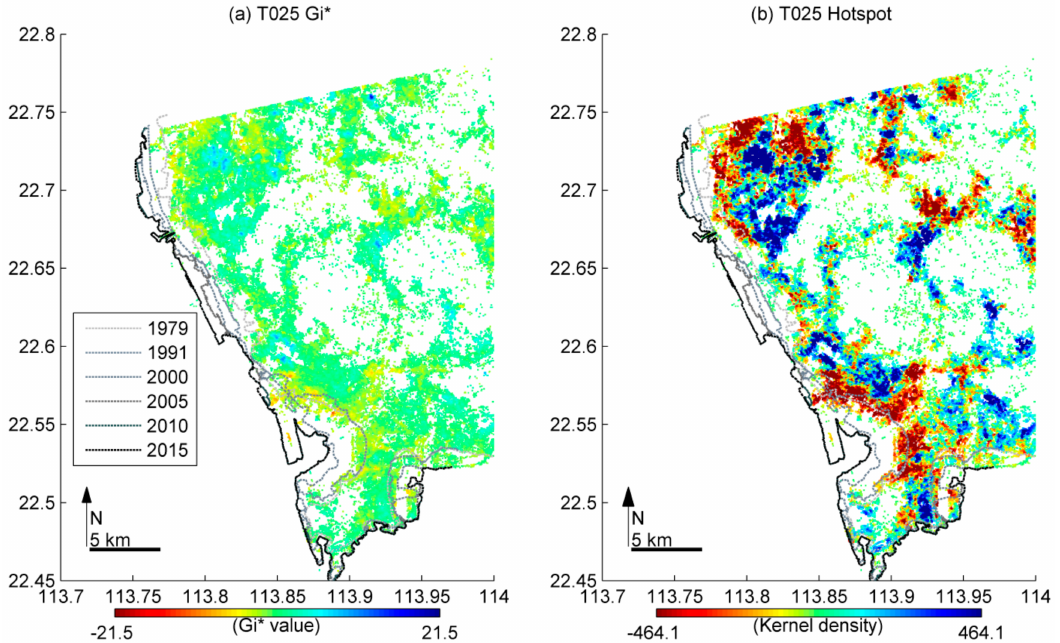
Figure A2. The clustering of mean rates using Getis–Ord Gi* statistic for ASAR T025. ( a ) Gi* values; ( b ) Hotspot map derived from a kernel density